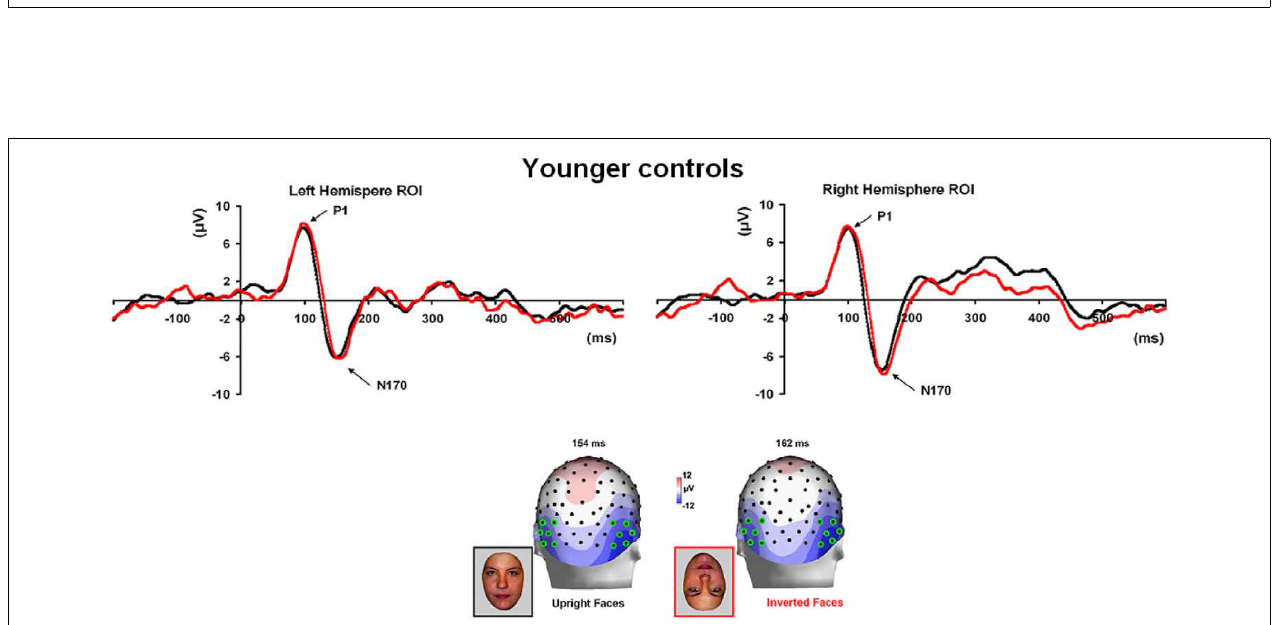
FIGUREA3 |This figure shows both the mean NFEI [Normalized Face Effect Index = (faces − cars)/(faces + cars)] and the mean NFII [Normalized Face Inversion Index = (inverted faces − upright faces)/(inverted faces + upright faces)] of the individually based analysis for both PS and controls.